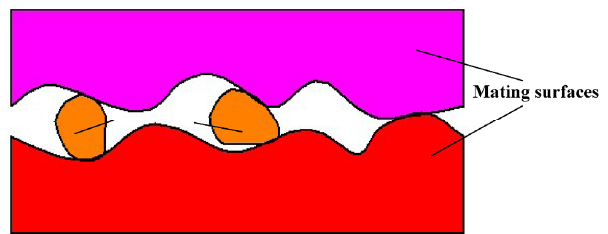
Fig. 7 Illustration of wear